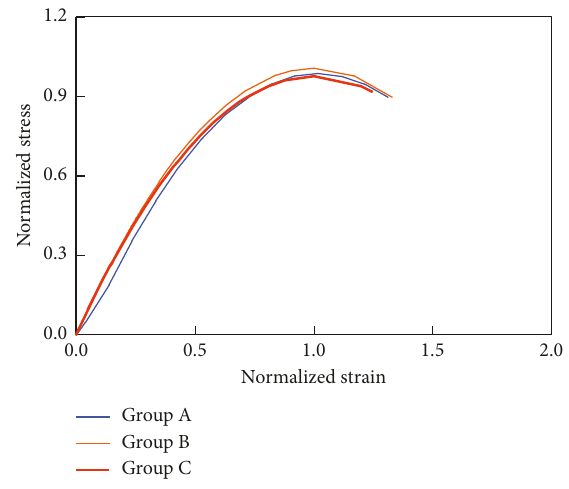
Figure 9: Stress-strain curves of masonry prisms in compression.